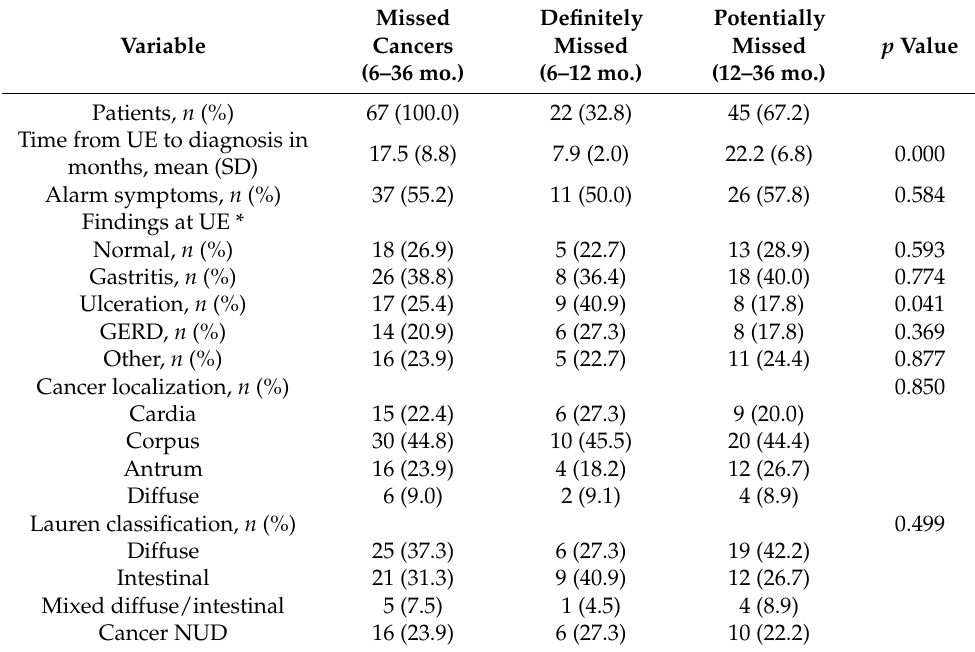
Table 2. Characteristics of gastric cancers diagnosed 6–12 months versus 12–36 months after a previous upper endoscopy.